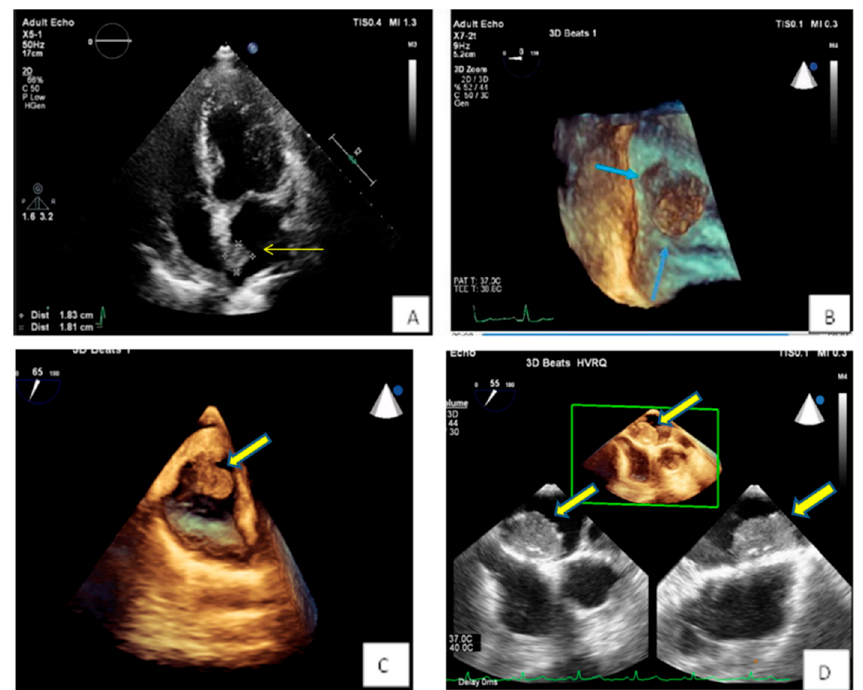
Figure 4. ( A , B ) Spherical lesion 1.8 × 1.8 cm attached through a wide base close to fossa ovalis was depicted at TTE ( A ) (yellow arrow) and subsequently TEE ( B ) (blue arrows—3D zoom). The location of the tumor in the left atrium as well as its morphological characteristics are compatible with a myxoma. ( C ) 3D TEE showing a polypoid (yellow arrow), with a smooth or mildly lobar surface located at the entrance of the inferior vena cava. Echocardiographic findings are consistent with a myxoma in a rare position. ( D ) 3D TEE depicting a large mass with spot calcific areas located at the fossa ovalis with a wide base, findings consistent with a left atrium myxoma. Please note the areas with higher echogenicity within the mass (yellow arrows).